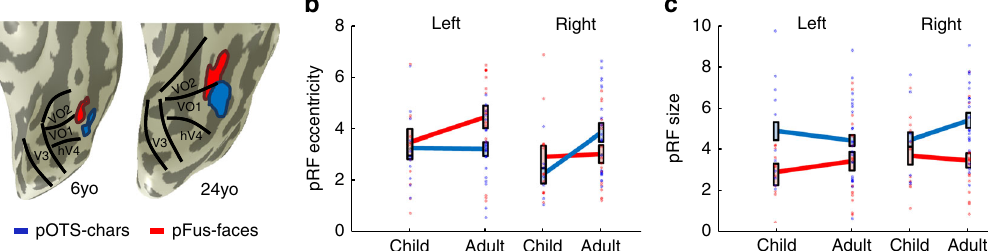
Fig. 3 Development of pRF eccentricity and size in face and word regions. a pFus-faces (red) and pOTS-chars (blue) on the left ventral temporal lobe in representative child and adult participants. Black lines: boundaries of visual fi eld maps. b Mean pRF eccentricity in pFus-faces (red) and pOTS-chars (blue) in children and adults, units are degrees of visual angle. Children are in light colors. c Mean pRF size in pFus-faces (red) and pOTS-chars (blue) in children and adults, units are degrees of visual angle. b , c Error bars: standard error across participants of an age group. Colored circles: individual participant data. Left pOTS-chars: 12 children, 22 adults; Right pOTS-chars: 8 children, 21 adults. Left pFus-faces: 11 children, 18 adults; Right pFus-faces 14 children, 18 adults and adults: left pOTS-chars K-S = 0.31, p < 0.01; right pOTS- chars K-S = 0.25, p < 0.01; right pFus-faces K-S = 0.13, p < 0.01; left pFus-faces K-S = 0.32, p < 0.01).